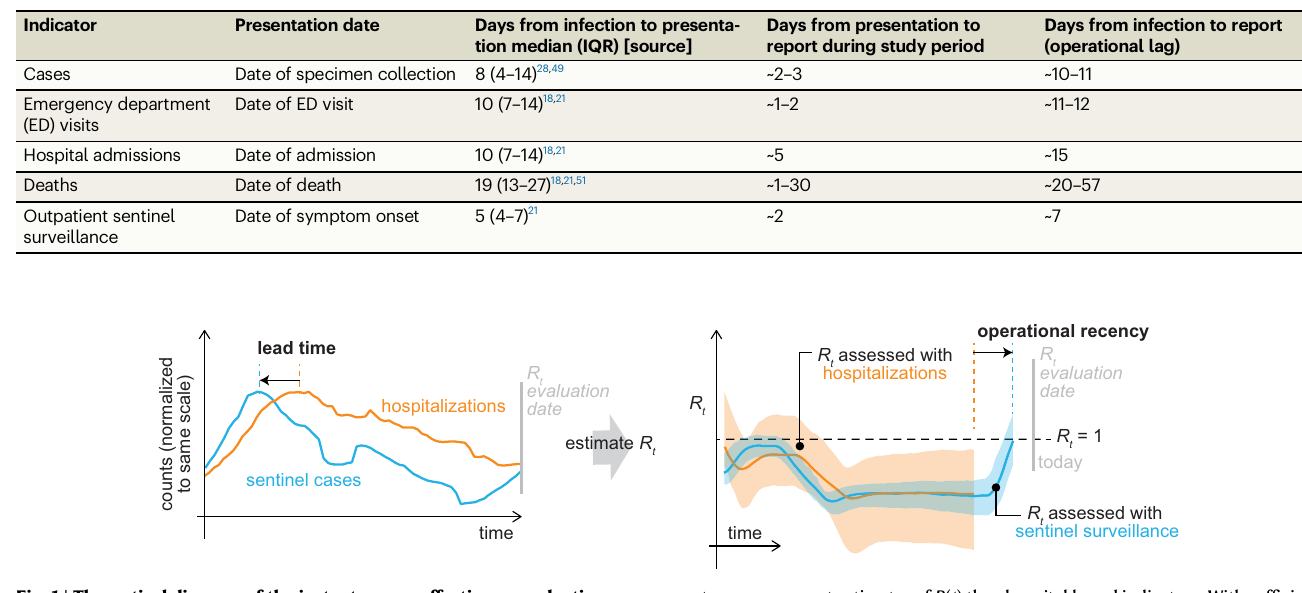
returnmorerecentestimatesof R ( t )thanhospital-basedindicators.Withsuf fi cient sample size, sentinel surveillance could also return more precise estimates of R ( t ) (shaded regions show theoretical con fi dence